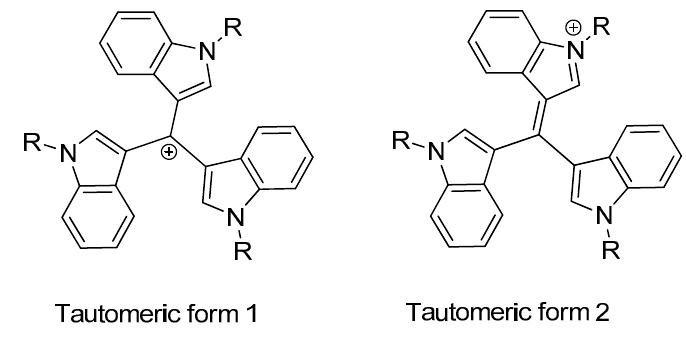
Figure 1. Tautomeric forms of compounds 8a–e. Table 2. Experimental and calculated values LogP ow for 8a–e